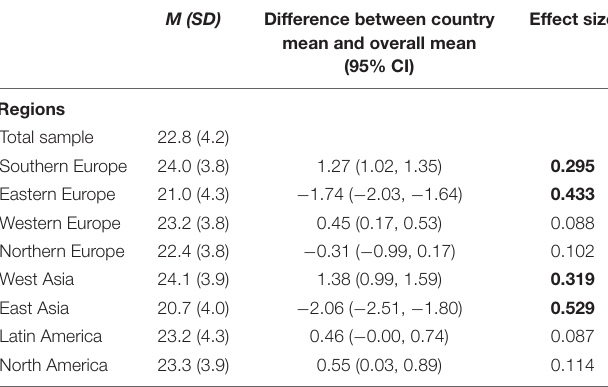
TABLE 2 | Average levels of prosocial behavior across regions. M (SD) Difference between country Effect mean and overall mean (95% CI)